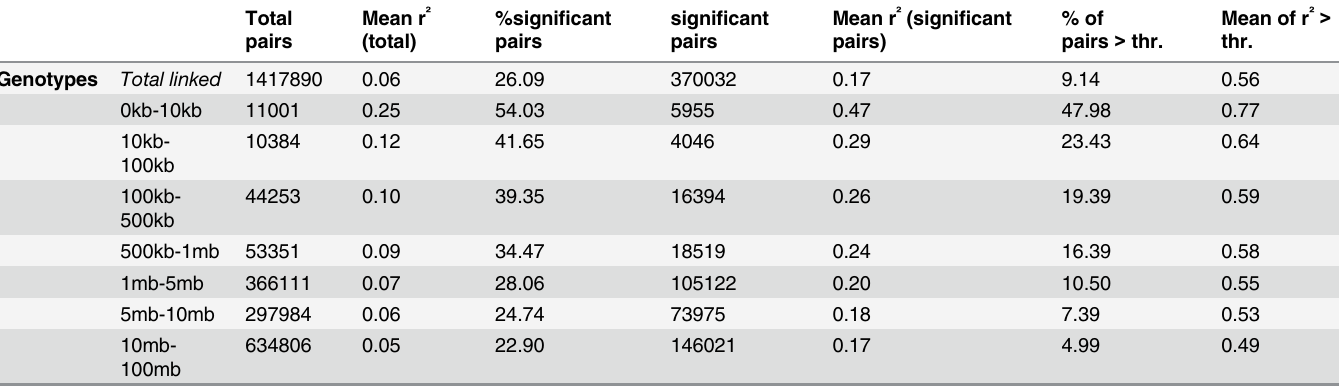
Table 2. LD expressed as squared allele frequency correlation ( r² ) calculated for the panel of 104 banana accessions selected for GWAS and geno- typed with 5544 markers. Total